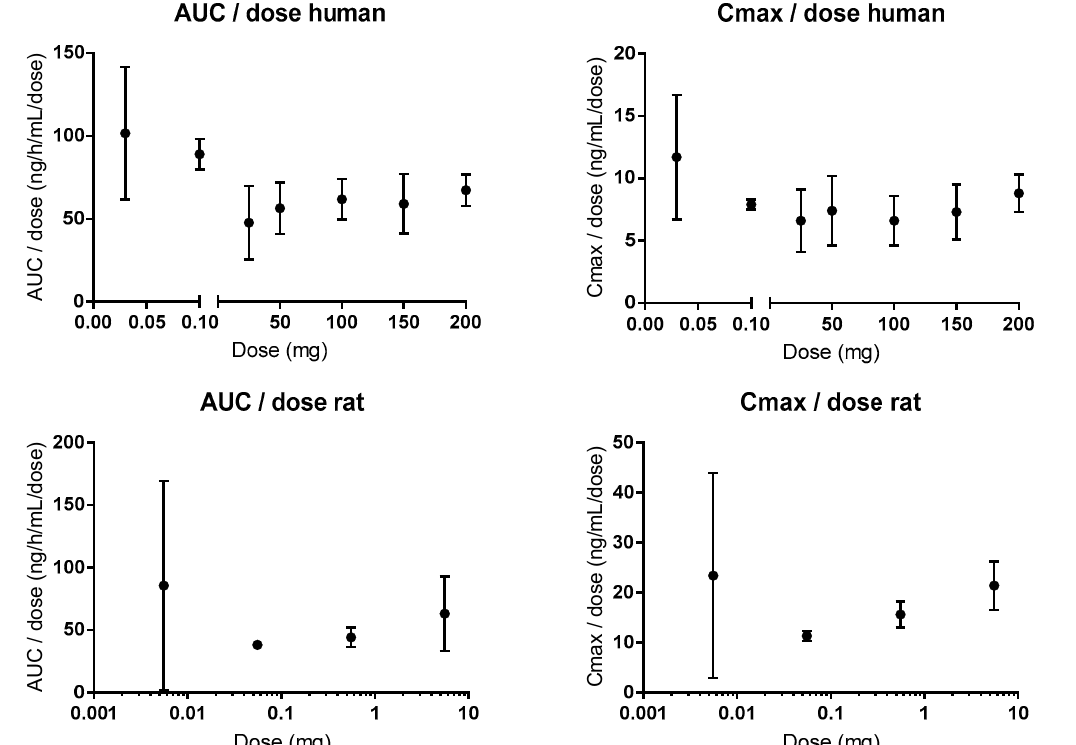
Figure 5. Dose proportionality in the area under the concentration-time curve ( AUC ) and maximum concentrations; ( Cmax ) of atenolol in humans (0.1–200 mg) and rats (0.55 µg–5.5 mg) [81–83,102]. Figures are made based on historical data.